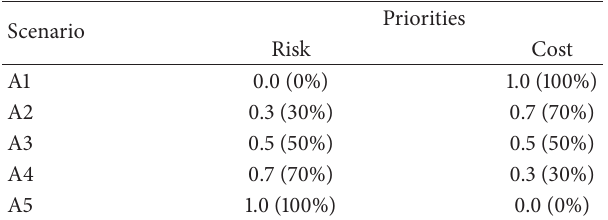
Table 2: Risk and cost priorities scenarios.